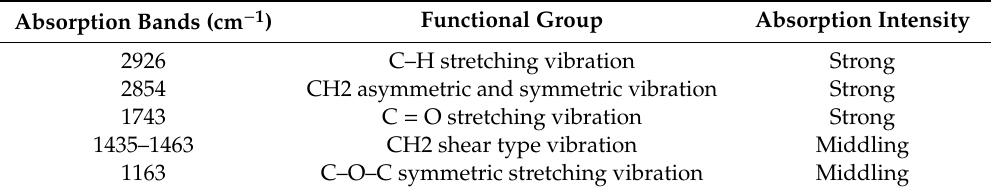
Table 7. Characteristic peaks of WCG in FT-IR spectra.